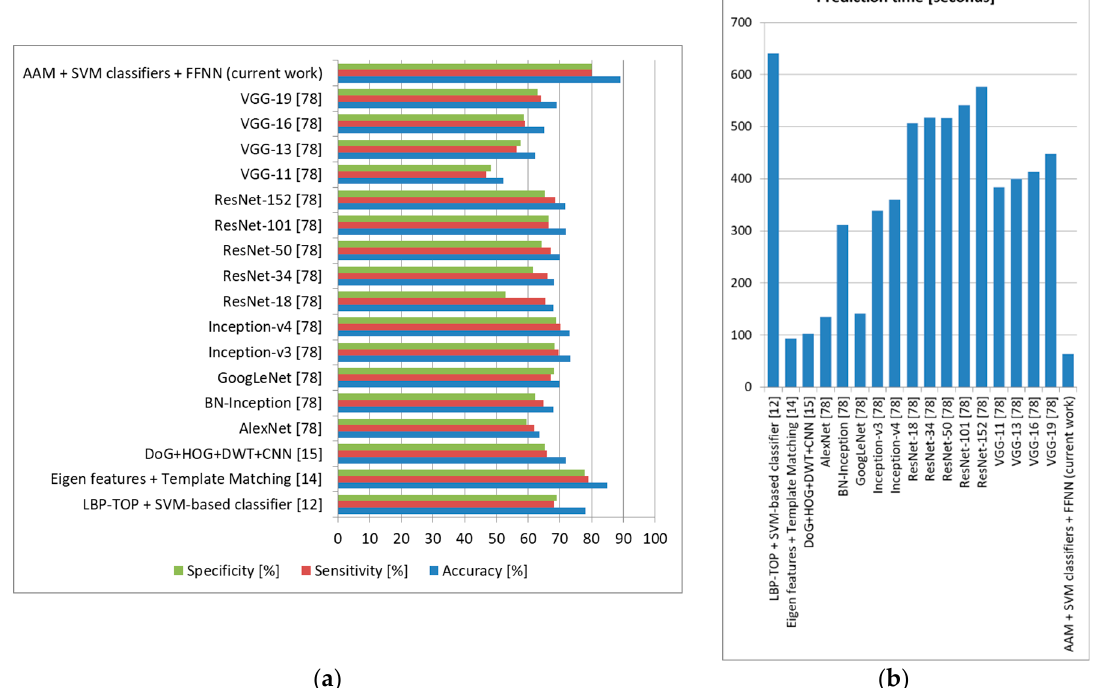
Figure 21. Stress prediction comparison to state-of-the-art methods (own database). ( a ) Average accuracy, sensitivity, and specificity, ( b ) Average prediction time (seconds).